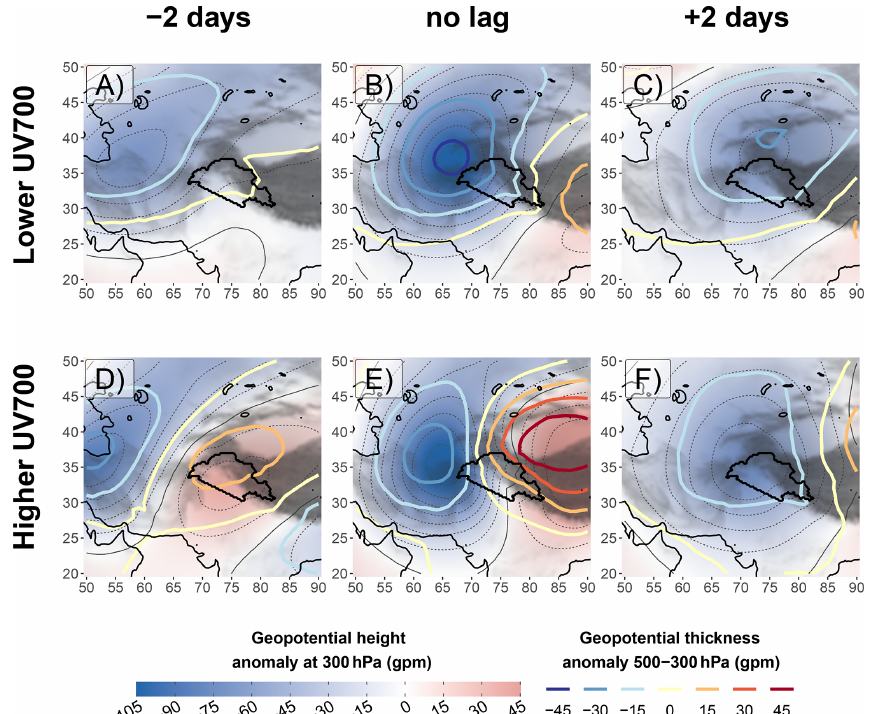
Figure 8. Same as Fig. 3, but the composites are based on a subsampling of lower (higher) values of UV700 while still being above the 90th percentile, in panels (a) to (c) ( d to f ). The subsampling is made so that it is not impacted by seasonality or by the intensity of the WD (see Sect. 3.3). This way, comparisons can be made with Fig.